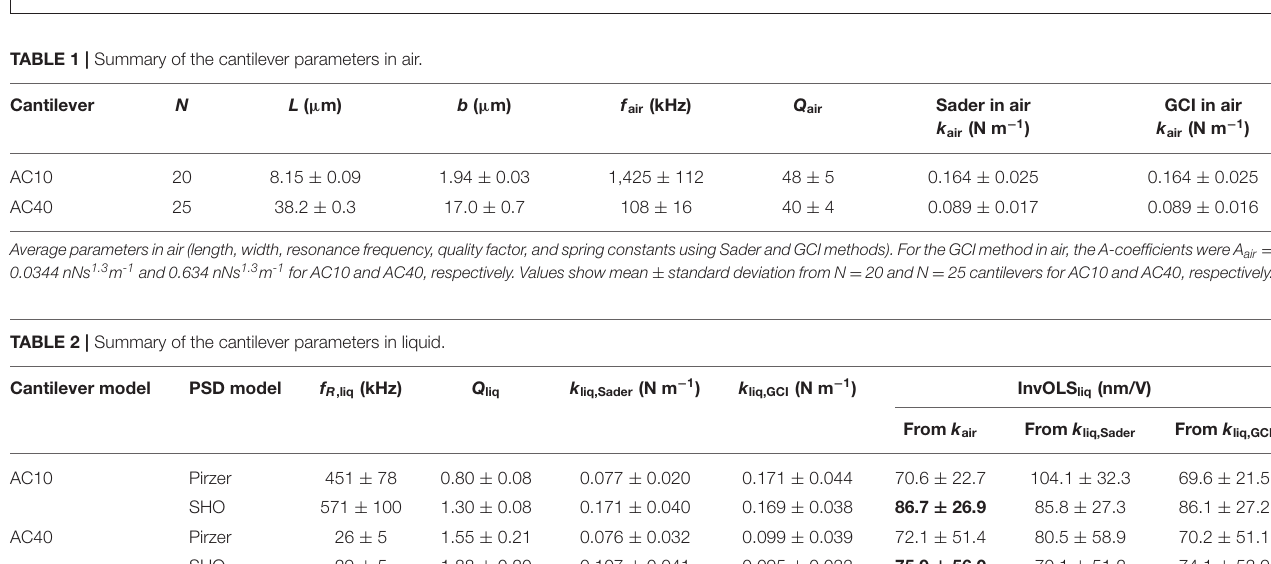
FIGURE 1 | Representative examples of thermal spectra in air (light gray dots) and liquid (dark gray dots) with the corresponding fit of the SHO model in air (solid dark gray line with f R = 1 453kHz and Q = 56 for AC10, left, and f R = 121kHz and Q = 50 for AC40, right) and SHO model in liquid (solid magenta line, with f R = 639kHz, Q = 1.26 and χ 2 = 0.75 for AC10, left, and f R = 34kHz, Q = 2.1 and χ 2 = 5.8 for AC40, right) and the Pirzer model in liquid (solid cyan line, with f R = 493kHz, Q = 0.73 and χ 2 = 1.01 for AC10, left, and f R = 31kHz, Q = 1.8 and χ 2 = 8.2 for AC40, right). The insets show plan view electron micrographs of each cantilever type.